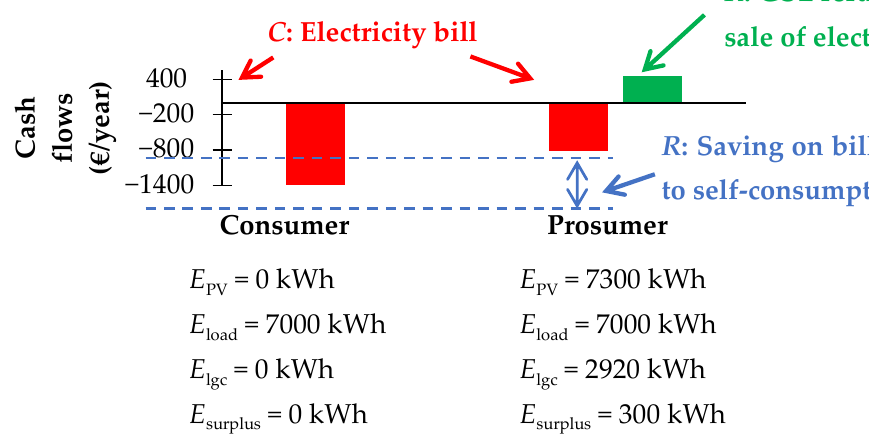
Figure 8. Consumer and prosumer economic annual balance. The annual net injection ( E surplus ) in the grid is equal to 300 kWh. The economic values of injection and absorption flows are, respectively, EUR ≈ 482 and EUR ≈ 449 (0.11 EUR/kWh); thus, GSE pays EUR ≈ 449 to the user. In addition, EUR 12 are obtained from the sale of E surplus to the grid (0.04 EUR/kWh), resulting in a total annual gain of EUR ≈ 461. The saving on the electricity bill is given by the avoided purchase of E lgc from the grid at 0.20 EUR/kWh (EUR 584): the passive user pays EUR 1400 (7000 kWh with a unitary cost of 0.20 EUR/kWh) for electricity, while the prosumer pays EUR 816 (4080